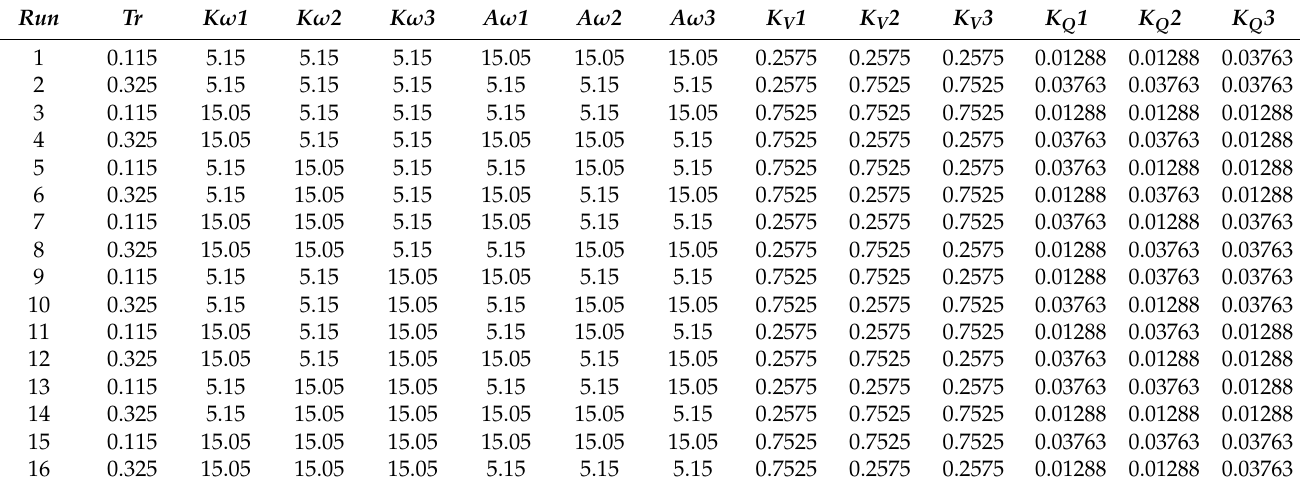
Table 3. Resolution III fractional factorial design